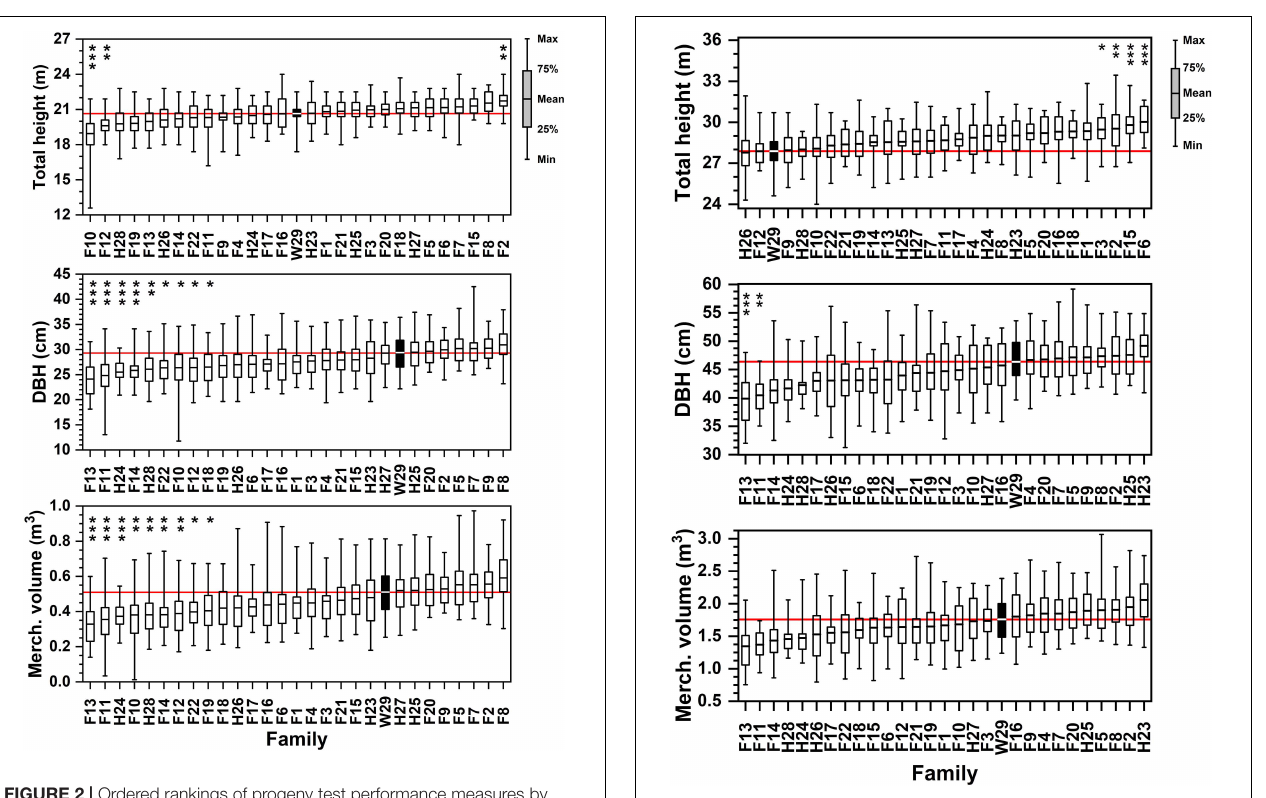
FIGURE 3 | Ordered rankings of progeny test performance measures by attribute (total tree height, DBH, merchantable volume) means from data collected in January 2017. The open-pollinated Crossett Experimental Forest family (W29) highlighted by black bar, with solid red line showing W29 mean value. Bars represented range of observed values from minimum to maximum; boxes represent 25th and 75th percentiles of sampled data. Asterisk (stacked vertically) above data reflect families significantly lower or higher than W29 at the following significance levels (* = 0.05 ≤ p < 0.01; ** = 0.01 ≤ p < 0.001; *** = p ≤